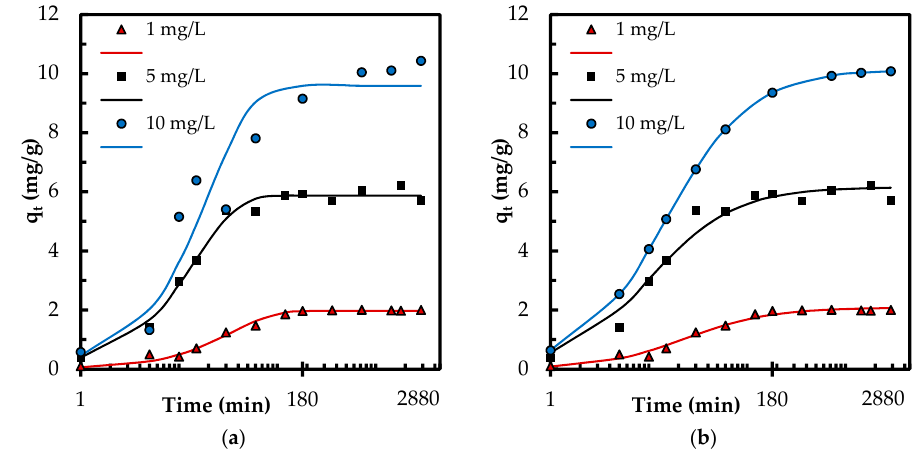
Figure 7. ( a ) Theoretical q t (lines) by pseudo-first-order kinetic model; and ( b ) theoretical q t (lines) by pseudo-second-order kinetic model determined by nonlinear regression compared to experimental q t (markers).